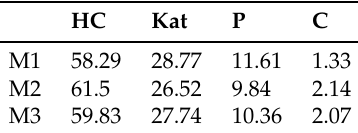
Table 5. Rietveld refinement of the mixing series of LDHs M1 = 500rpm, M2 = 750rpm and M3 = 1000rpm. HC indicates the phase [Ca 4 Al 2 (OH) 12 ][(CO 3 ) · 5H 2 O], Kat is katoite, P is portlandite and C is calcite. All values are given in percentages of the crystalline phases.